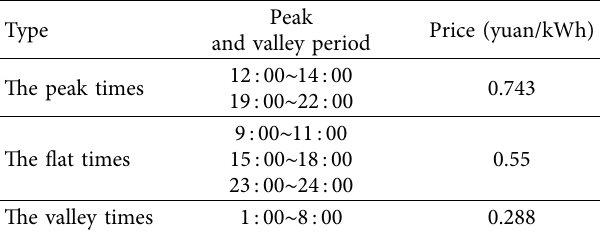
Figure 4: Temporal change of load trend with scenario. Table 1: Time-dependent electricity price.